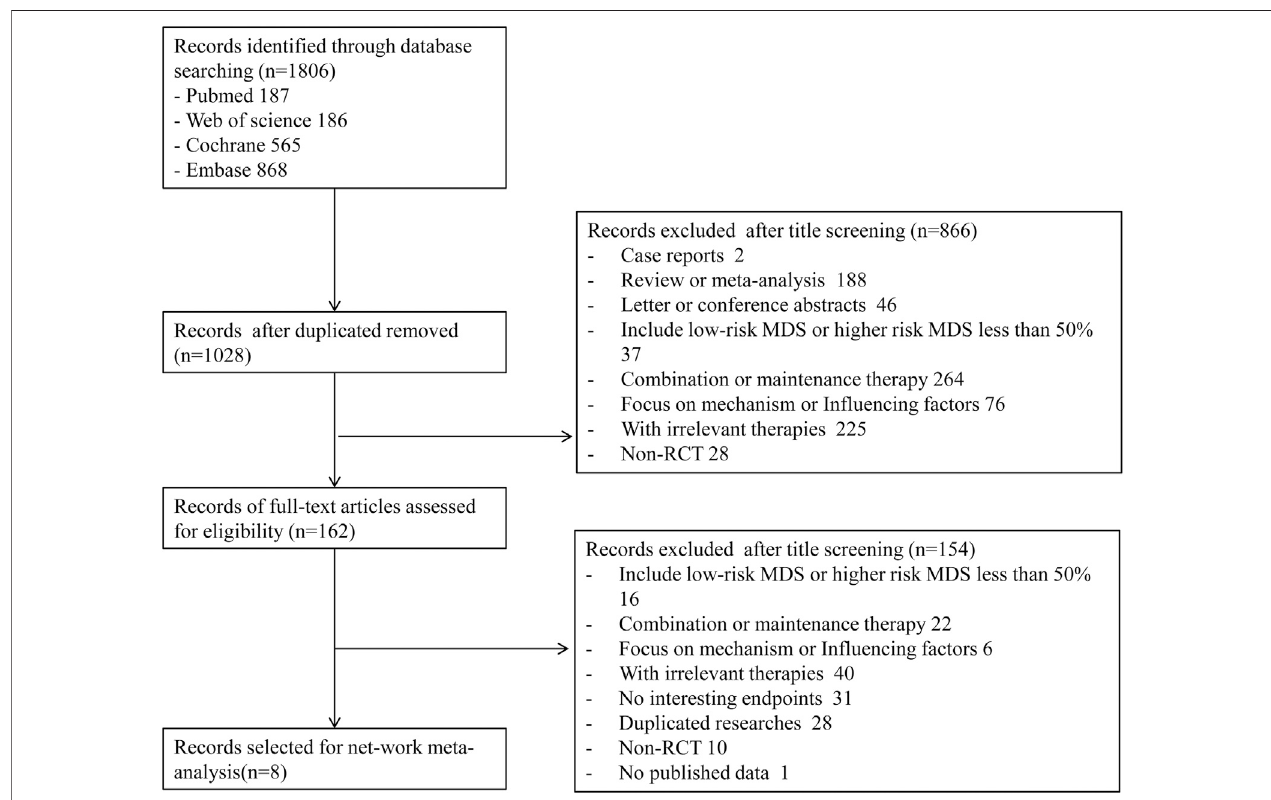
FIGURE 1 | Flowchart presenting the steps of the literature search and selection.